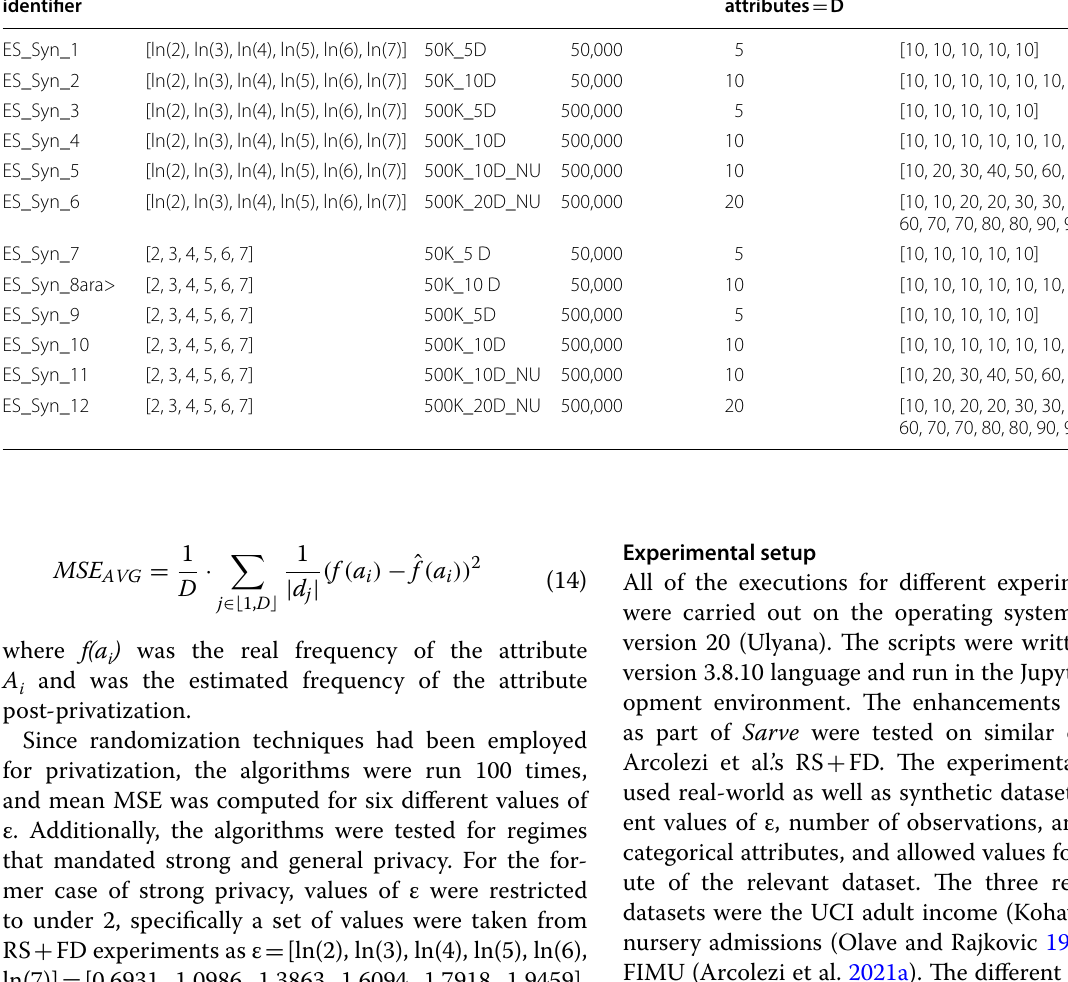
Table 2 The various parameter values that comprised experimental setup tested on synthetic datasets Experimental